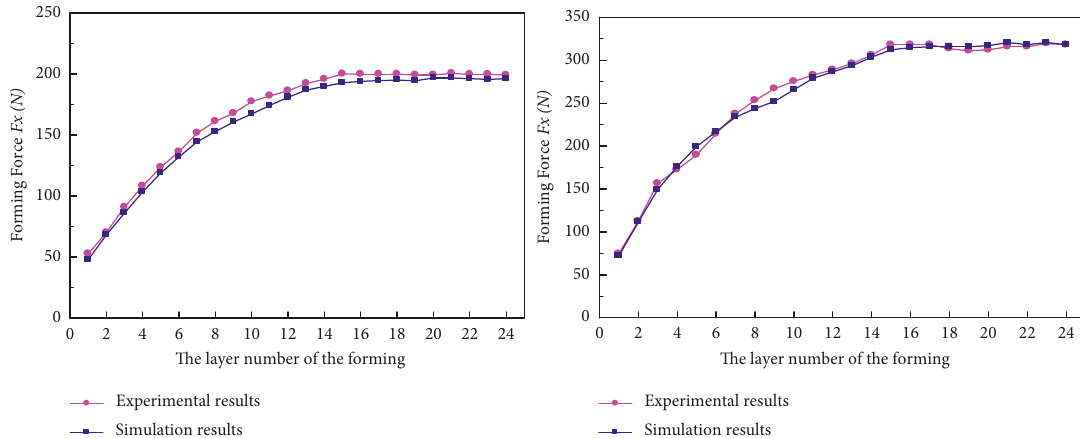
Figure 13: Comparison of simulated forming force and experimental forming force: (a) 1# formed part and (b) 45# formed